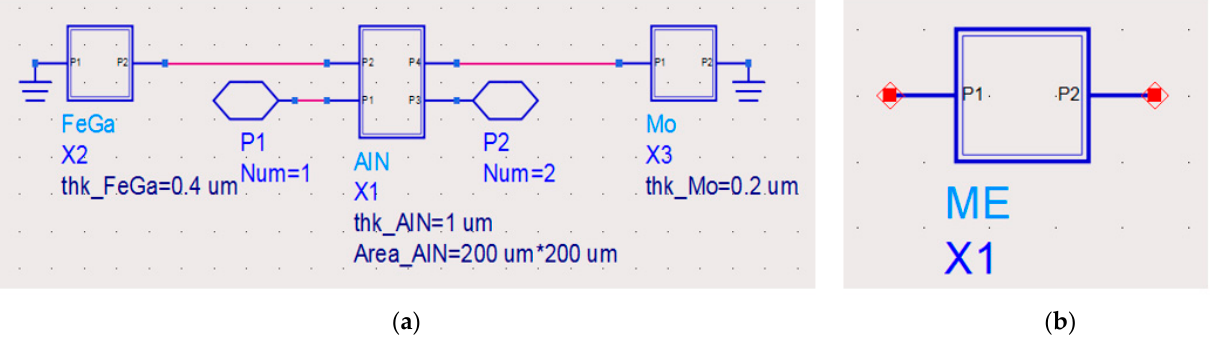
Figure 3. ( a ) The cascade diagram of the ME antenna, and ( b ) the ME antenna encapsulation. The electrical impedance of the antenna can be simulated by the circuit diagram shown in Figure 4, and the results shown in Figure 4a are the amplitude–frequency characteristic curve of the antenna, and Figure 4b is the phase–frequency characteristic of the antenna impedance curve. It can be seen from the simulation results that the ME antenna has two resonance frequencies—namely, the series resonance frequency is 2.305 GHz, and the parallel resonance frequency is 2.36 GHz.